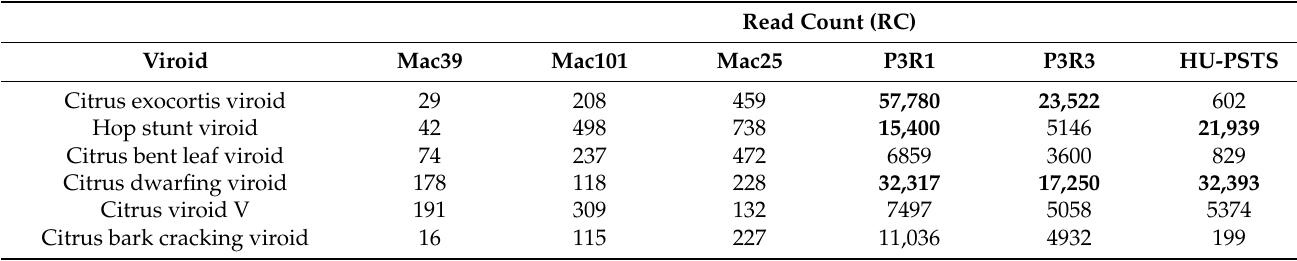
Table 4. Number of read counts obtained after alignments of siRNA libraries with viroids reference genomes. Positive identifications are in bold, considering a threshold limit of 15,000